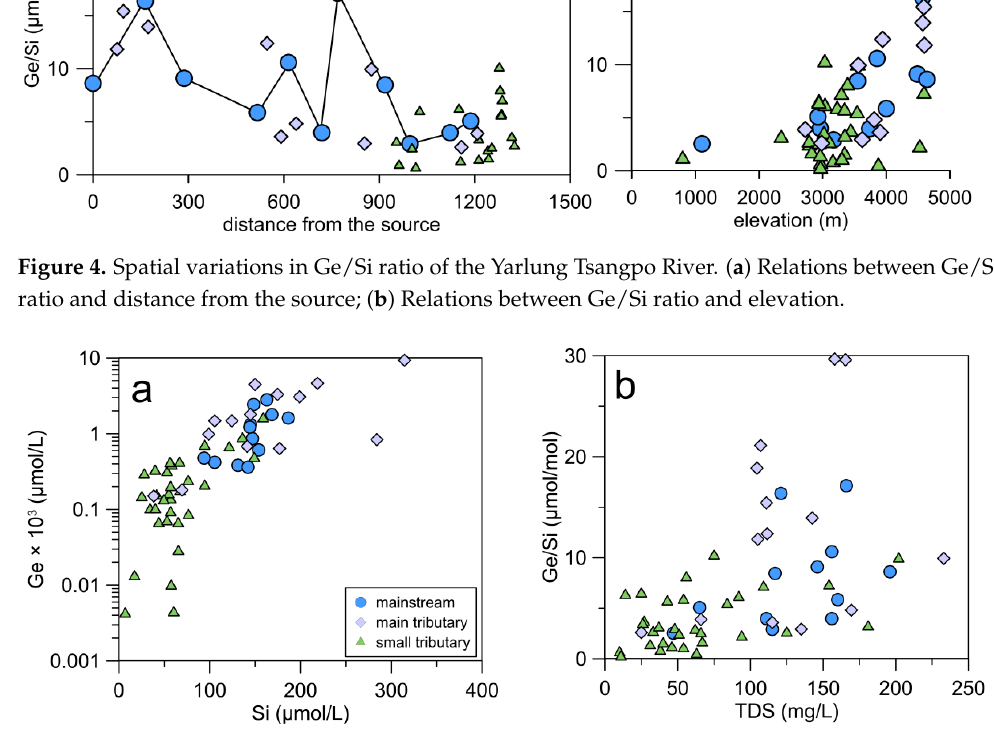
Figure 6. The relation between Si and Ge/Si in river water. The line for global clean rivers is from [17] . The tributary Xiangqu is characterized by the distribution of geothermal springs around its source area. The Ge/Si ratio of weekly time series river water samples in the Xiangqu show an obvious relationship with river discharge. As discharge increases, the Ge/Si ratio of river water decreases (Figure 7). In rivers affected by hydrothermal inputs, such as the mainstream of the Yarlung Tsangpo River, Xiangqu, and Nepali rivers [30], a low Ge/Si ratio of river water is observed at the high-flow period. This suggests the dilu- tion of the hydrothermal water input during the high-flow period. However, in the silicate